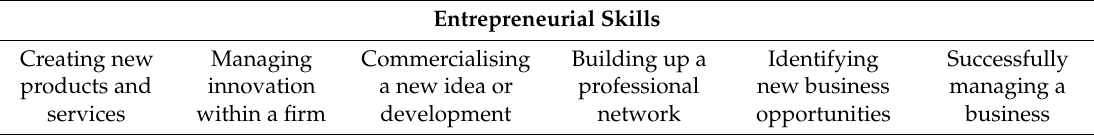
Table 7. Six skills on which the students were asked to give a self-assessment.